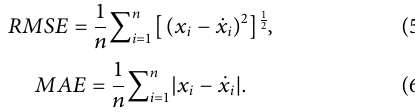
Here, n denotes the number of observations, the actual measured data are given by x i , and _ x i denotes predicted value at that instant.